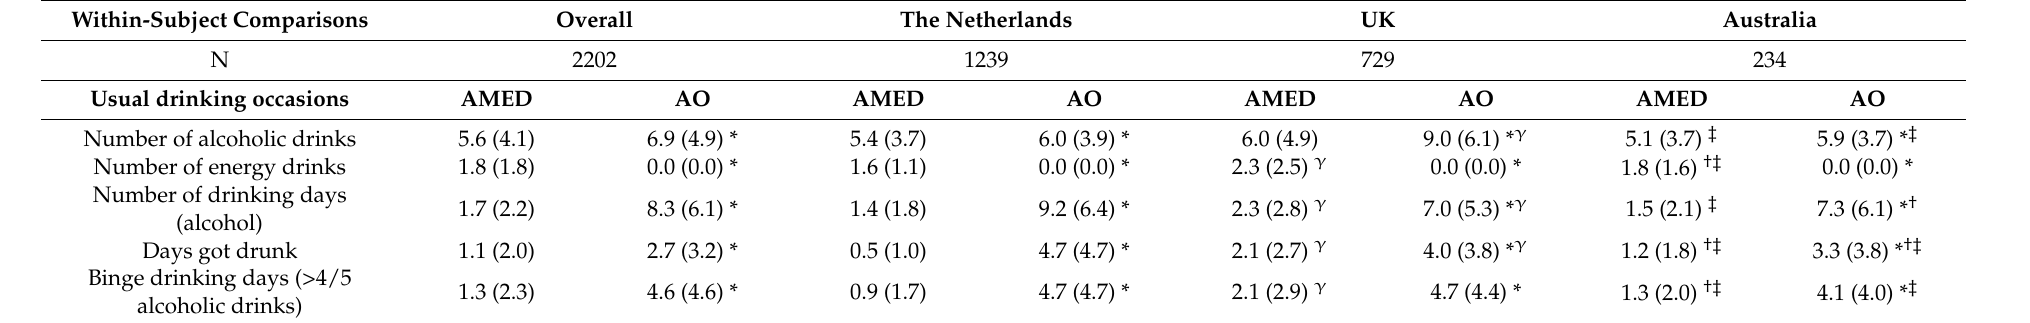
Table 4. Alcohol consumption of AMED consumers on usual AMED and AO occasions (within-subject